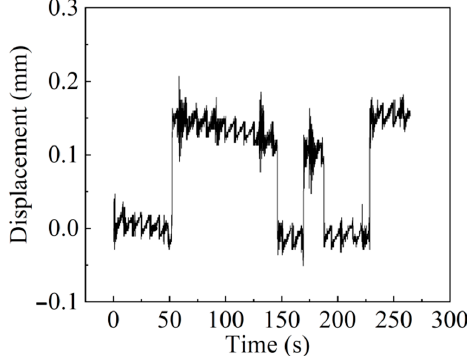
Figure 14. Sensor dynamic test results.